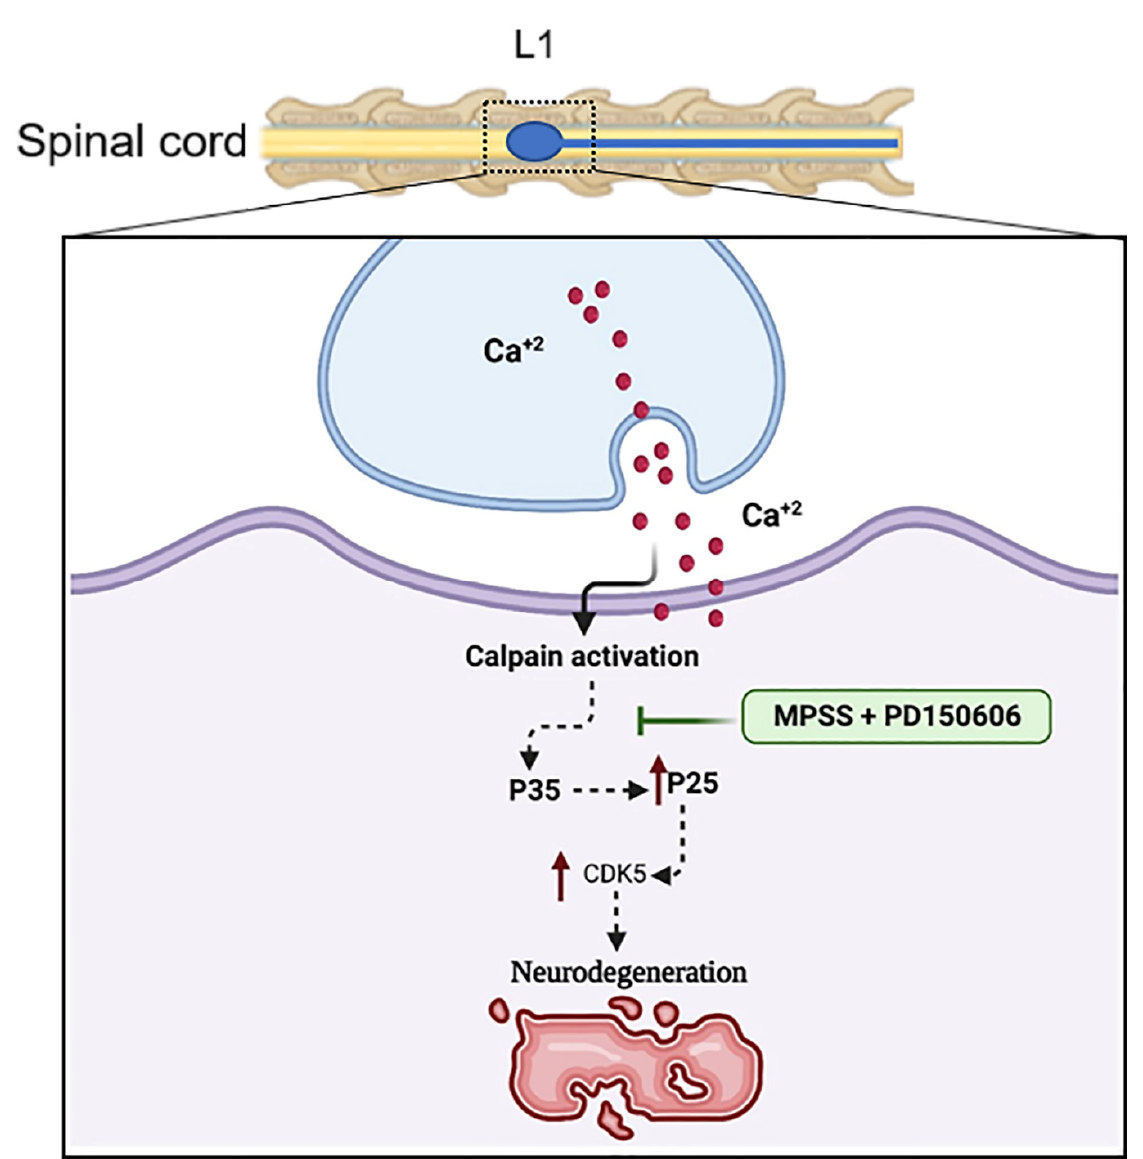
Figure 10. The calpain inhibition mechanism in SCI. Spinal cord compression causes an increase in calcium influx. The cleavage of p35 to p25 caused by calcium-dependent calpain activation leads to Cdk5 activation, which causes neurodegeneration. The MPSS and PD150606 combination inhibit calpain activation to maintain neuronal integrity.